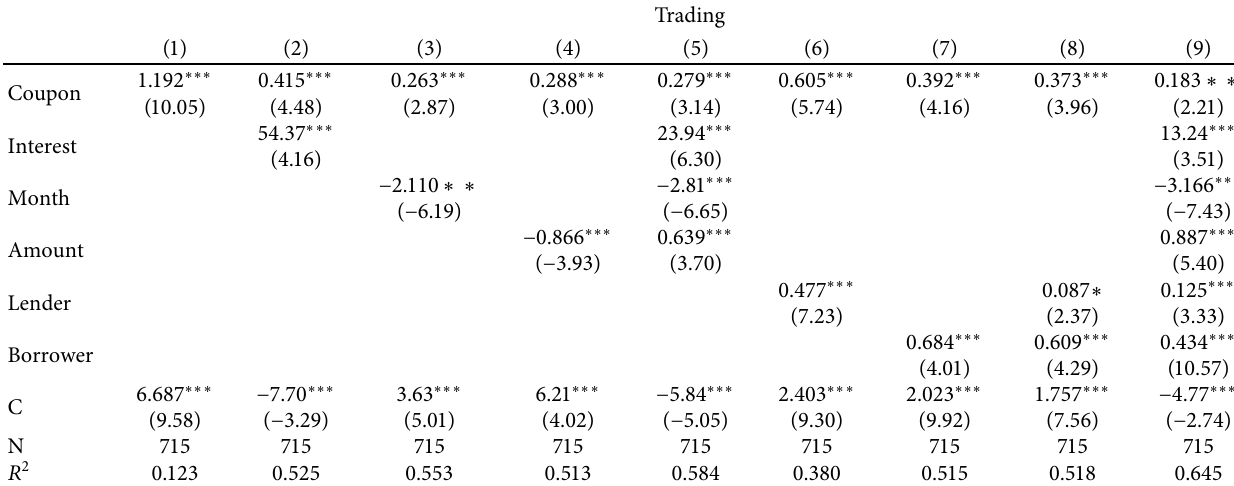
Table 9: The influence of coupon strategy on the trading number.